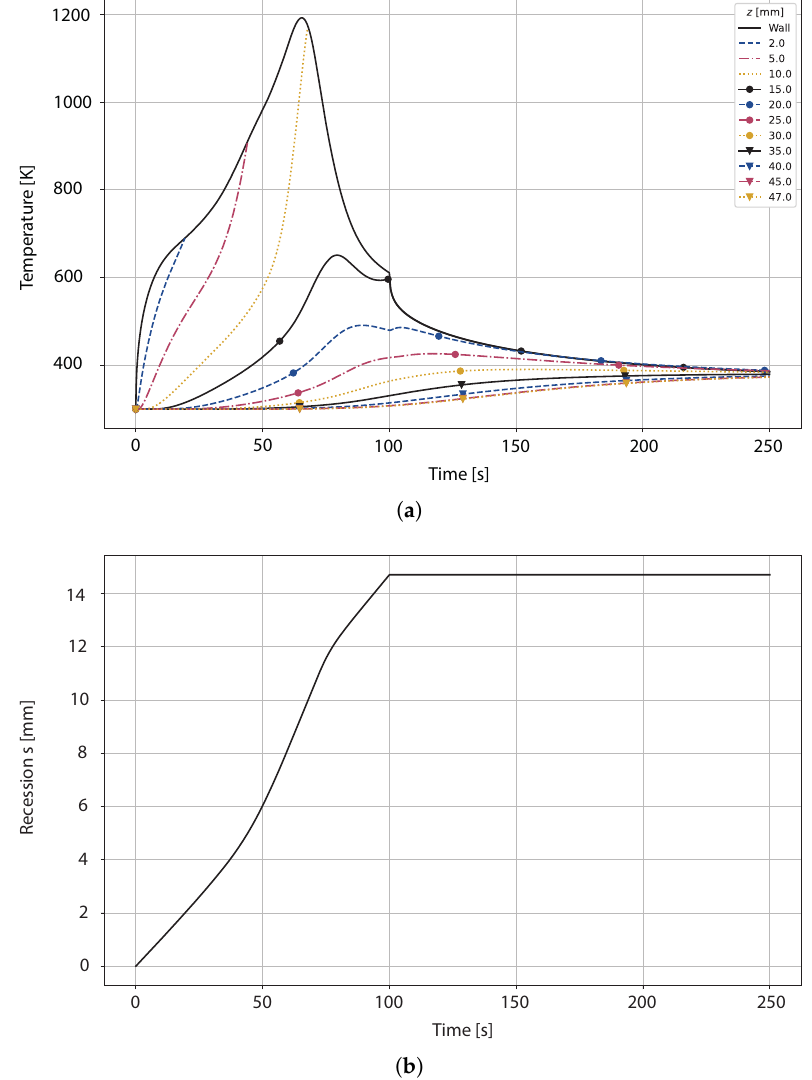
Figure 10. ( a ) Temperature evolution during re-entry. Wall indicates the receding outer surface, whereas the other temperature curves are at fixed z coordinate; ( b ) material recession of the ablative PICA TPS during